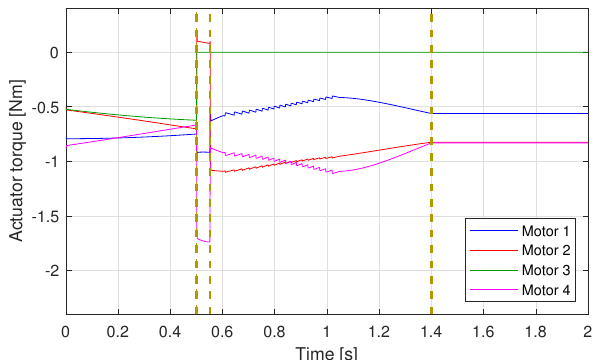
Figure 13. Motor torques during the recovery approach for motor 1 ( blue ), motor 2 ( red ), motor 3 ( green ) and motor 4